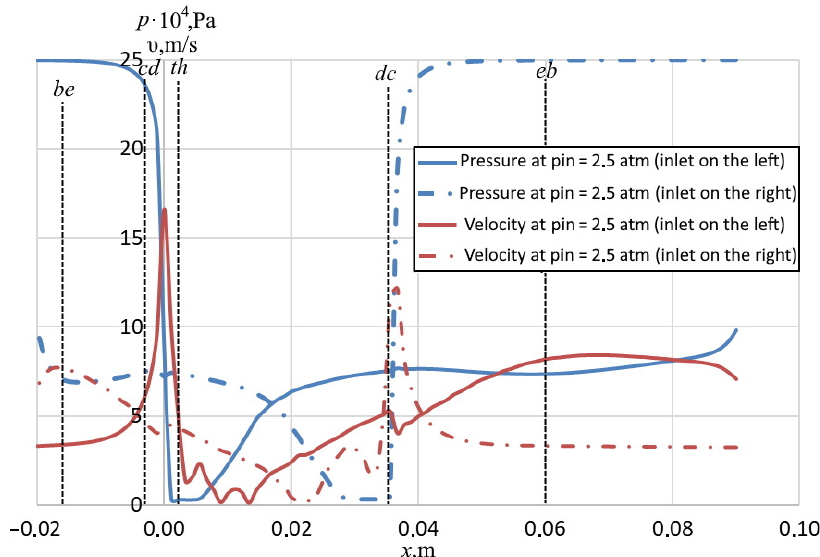
Figure 9. Absolute pressure p abs and flow velocity υ along cylindrical nozzle (from our CFD results). Cavitation appears in the transition from wide to narrow section in the direction of flow. The length of cavitation region in this case was l cavi = 10 mm The maximum vapor concentration is 80% (Figure 10a,b). When inlet pressure was increased to 2.8 atm, the entire throat was filled with vapor ( l cavi = 32 mm). The cavitation zone significantly in- creases but maximum volume fraction stays the same (Figure 10c,d). Inception cavitation number for the case of cylindrical nozzle is significantly higher than in the case of Venturi tube in all characteristic points. The last type of nozzle tested in this study was the convergent/divergent nozzle (Fig- ure 3c). Figure 11 shows absolute pressure (blue line) and the flow velocity υ (red line) along the conical nozzle including the case with switched inlet. The characteristic points were determined when the cone acts as a diffuser or confuser for the fluid flow. For the smooth expansion of the flow (diffuser case), cavitation inception is observed at p in = 1.35 atm and the cavity zone ( l cavi = 10 mm) gradually increases with increasing pressure (Fig- ure 12). The critical pressure drop for cavitation inception was 0.35 atm. For the reversed case (converging nozzle) the phase transition starts only at p in = 2.8 atm, and slowly in- creases with increasing pressure.